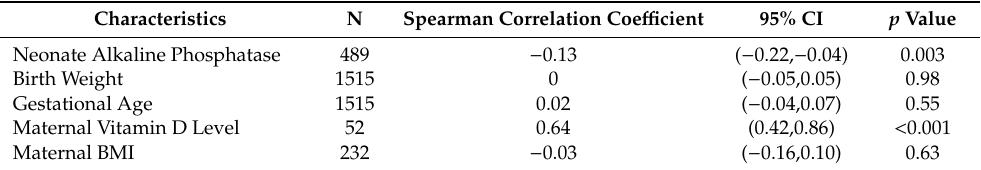
Table 4. Association of continuous characteristics with infant vitamin D levels.